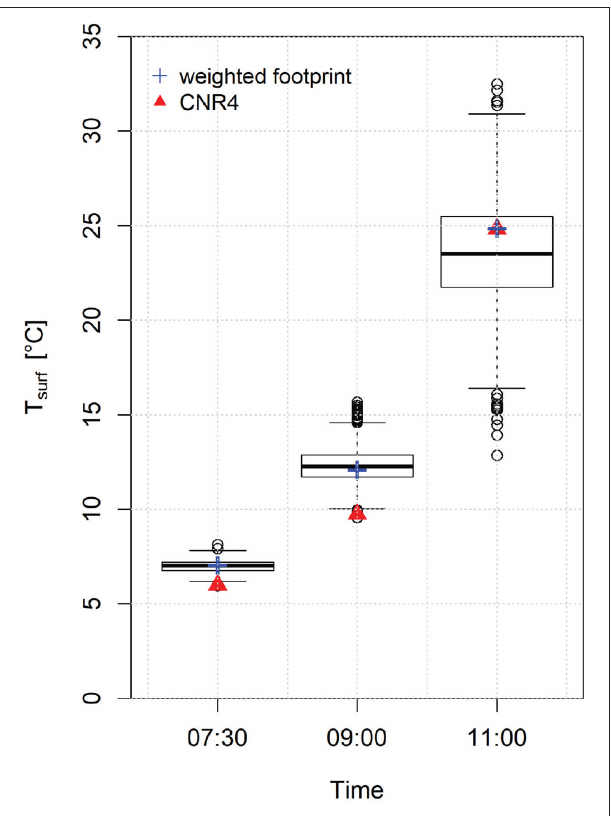
FIGURE 11 | Surface temperatures measured by the UAV over the whole footprint at the corresponding time (boxplot), the corresponding weighted footprint temperature and the measurement from the